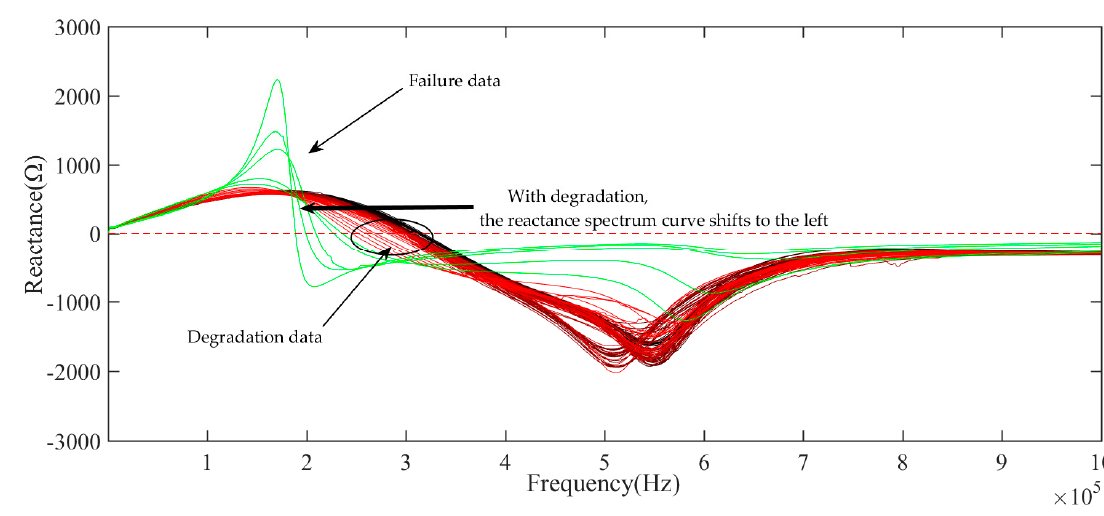
Sensors 2021 , 21 , x FOR PEER REVIEW Figure 6. The measurement value of inductance spectra of the electromagnetic coil in the whole life.